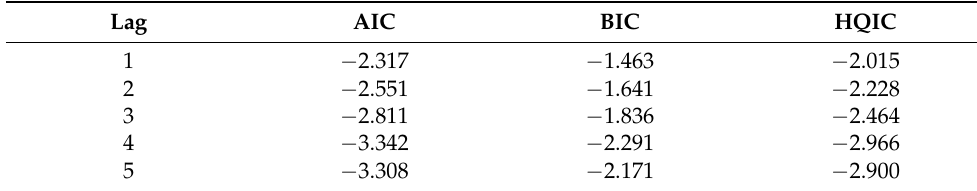
Table 5. Results of multi-criteria joint judgement.